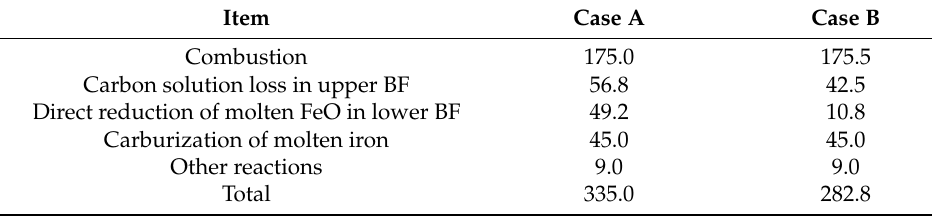
Table 9. Distributions of coke consumption in cases A and B